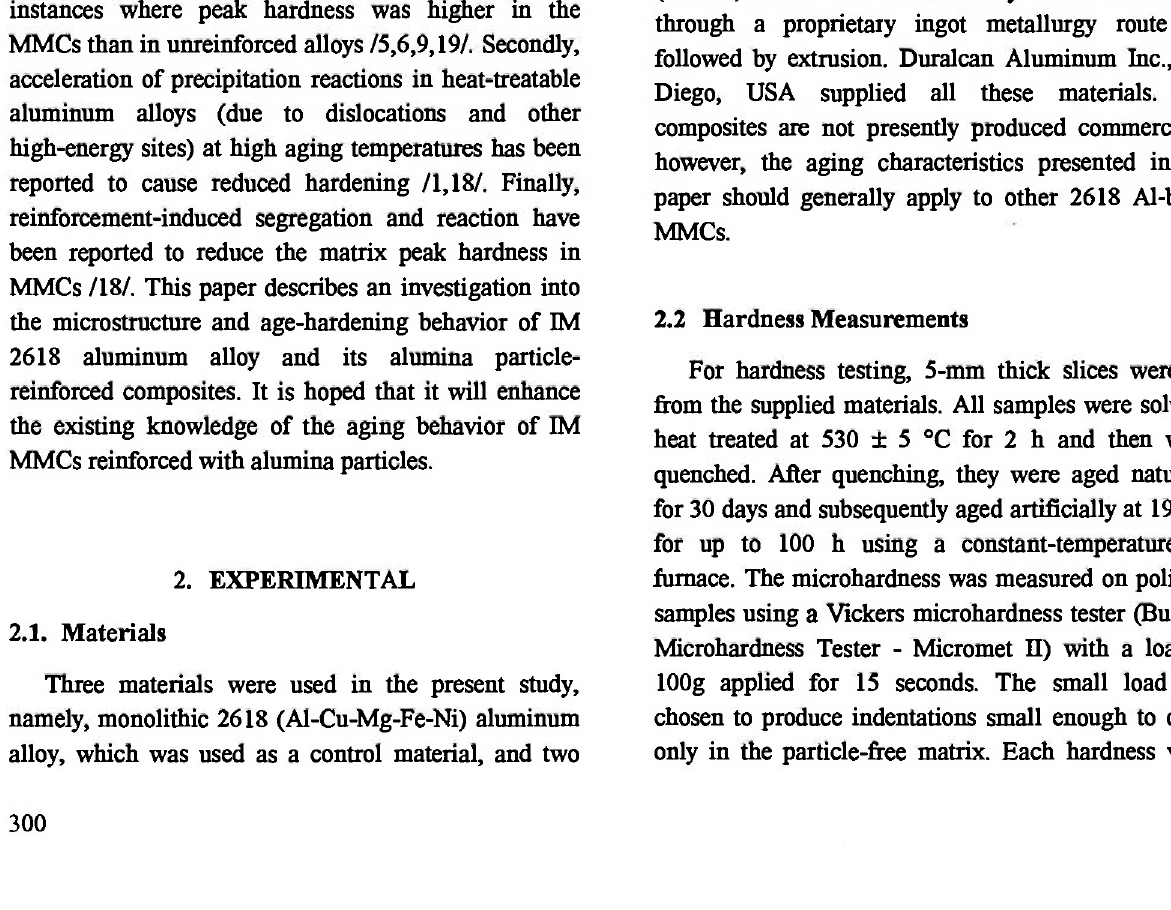
Fig. 1: Tue morphology of alumina particles 2618 Al composites containing 10 and 15-vol. % of alumina (AI2O3) particles, respectively. The geometry of the alumina particles is angular (see Figure 1) with the longest dimension ranging from 2-20 μιη. Table 1 shows the elemental composition of typical